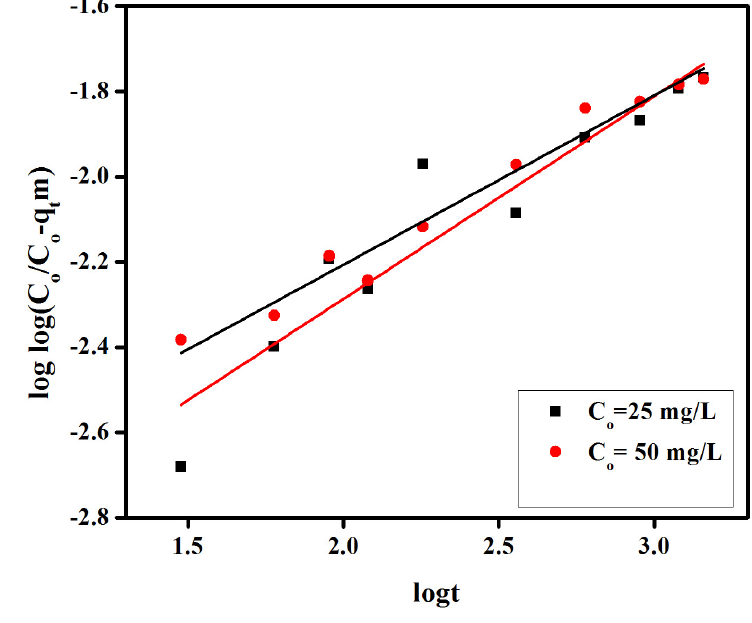
Figure 10. Bangham ʼ s plot of loglog(Co/Co-qtm) vs. logt for adsorption of congo red on anion exchange membrane